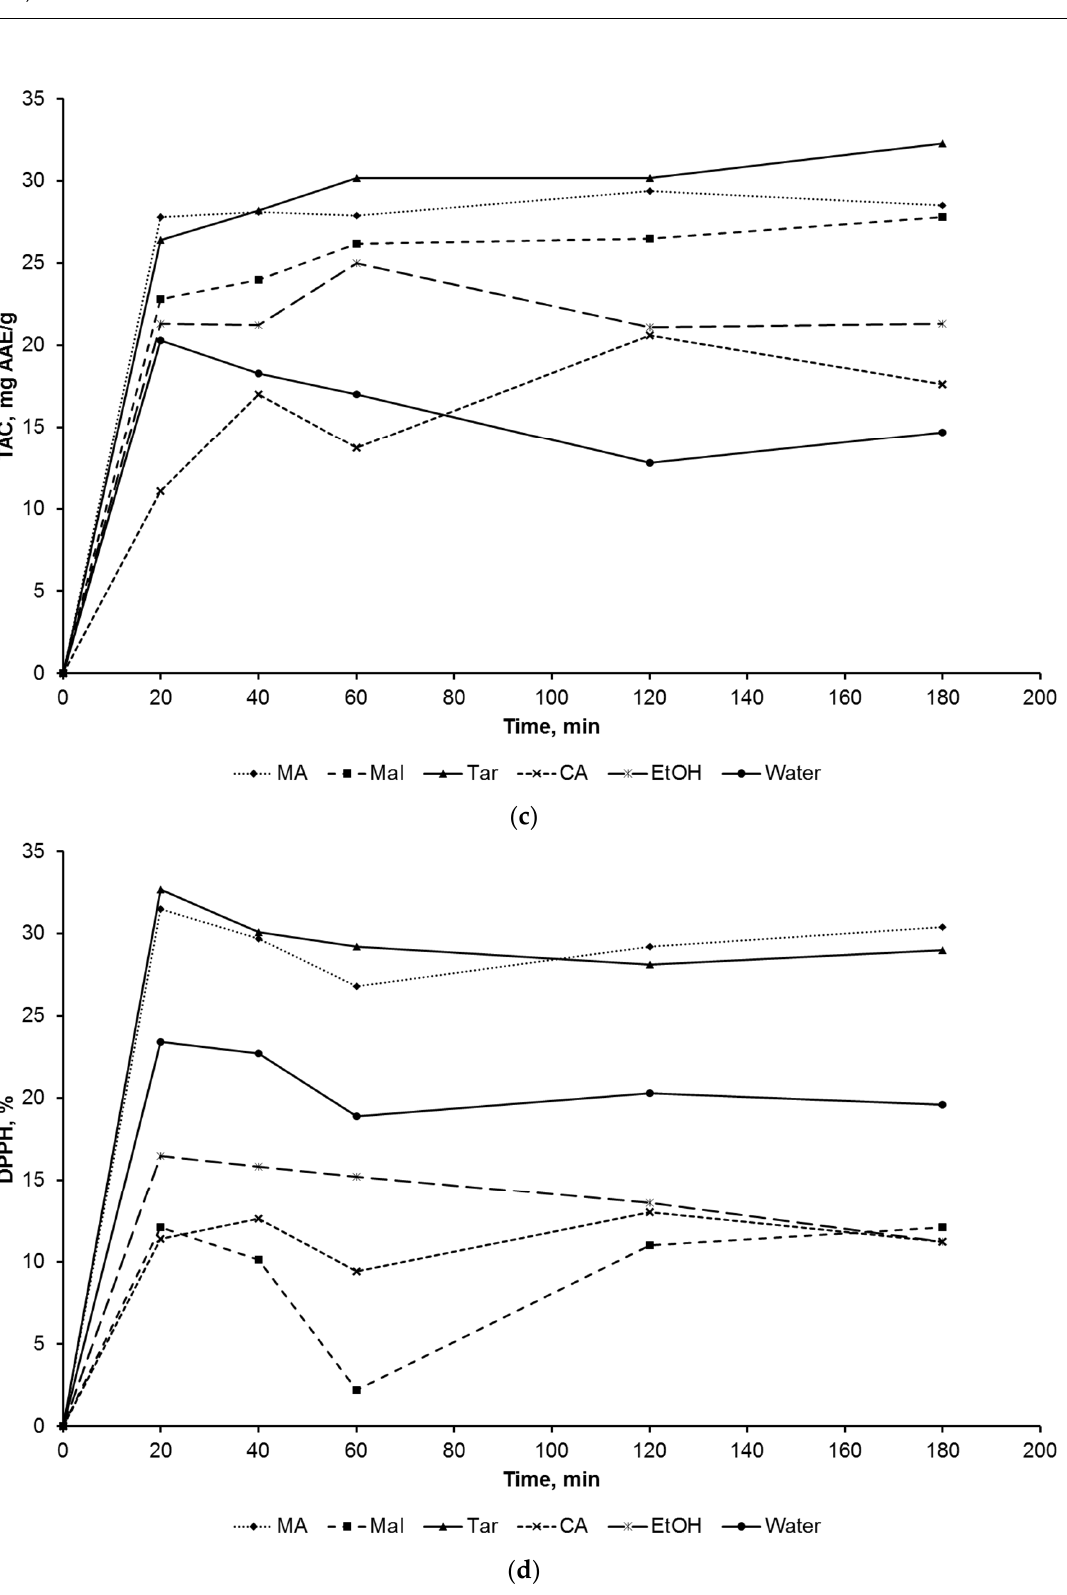
Figure 1. Time dependence of rosavin ( a ), TPC ( b ), TAC ( c ), and DPPH ( d ) concentrations for NADES ‐ based choline chloride and malonic (MA), malic (Mal), tartaric (Tar), and citric (CA) acids, 90% v / v ethanol (EtOH) and water.